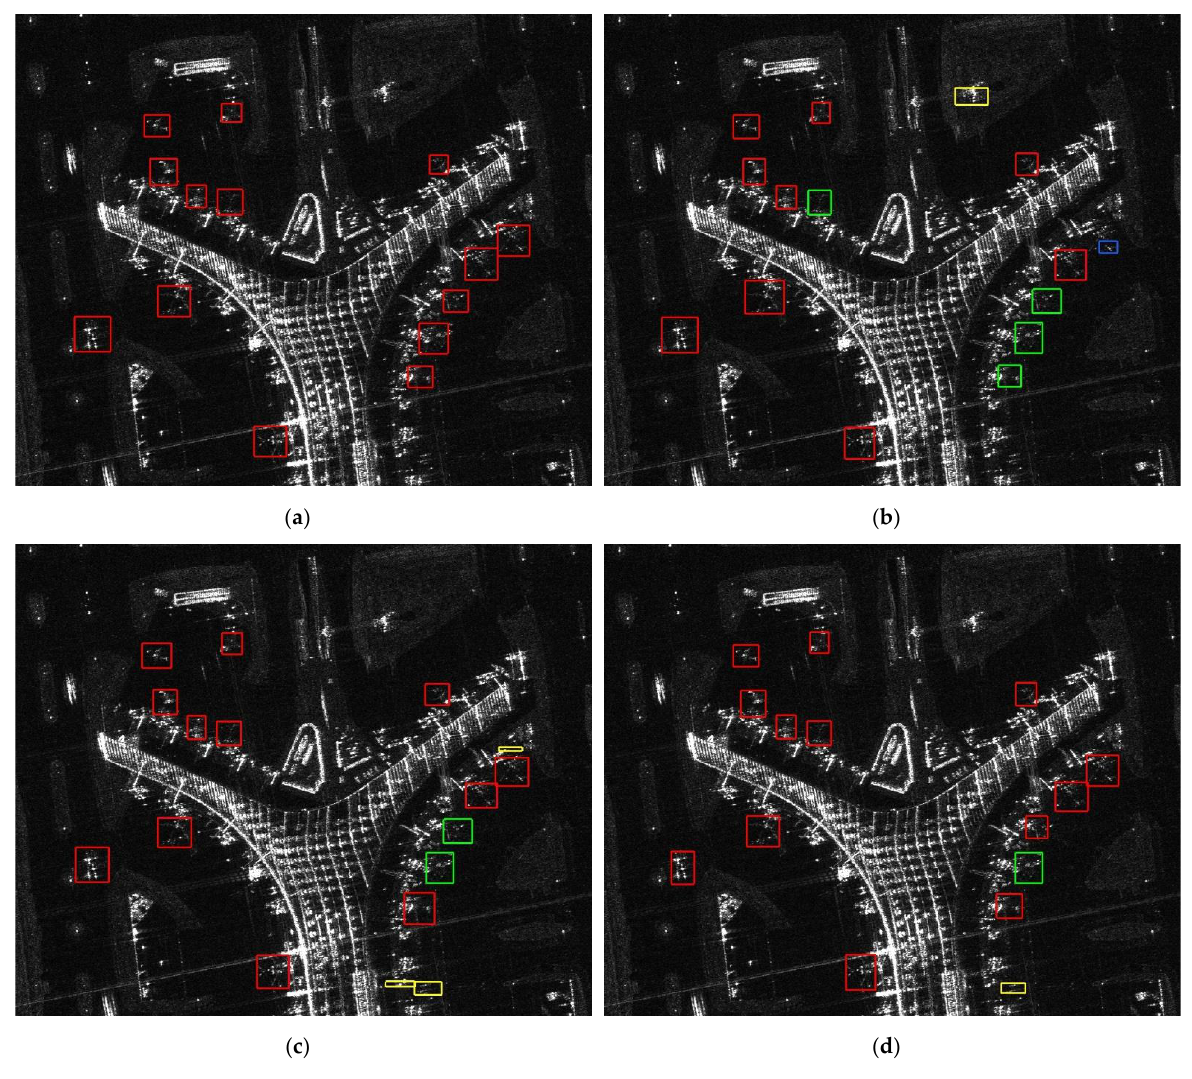
Figure 9. The results for scene II of Beijing Capital Airport. ( a ) The ground truth from Gaofen-3. ( b – d ) The detection results by YOLOv5, YOLOX, and SOAEN, respectively. The correct detection, the missed detection, the false alarms, and the inaccurate bounding boxes are indicated by red, green, yellow, and blue boxes,